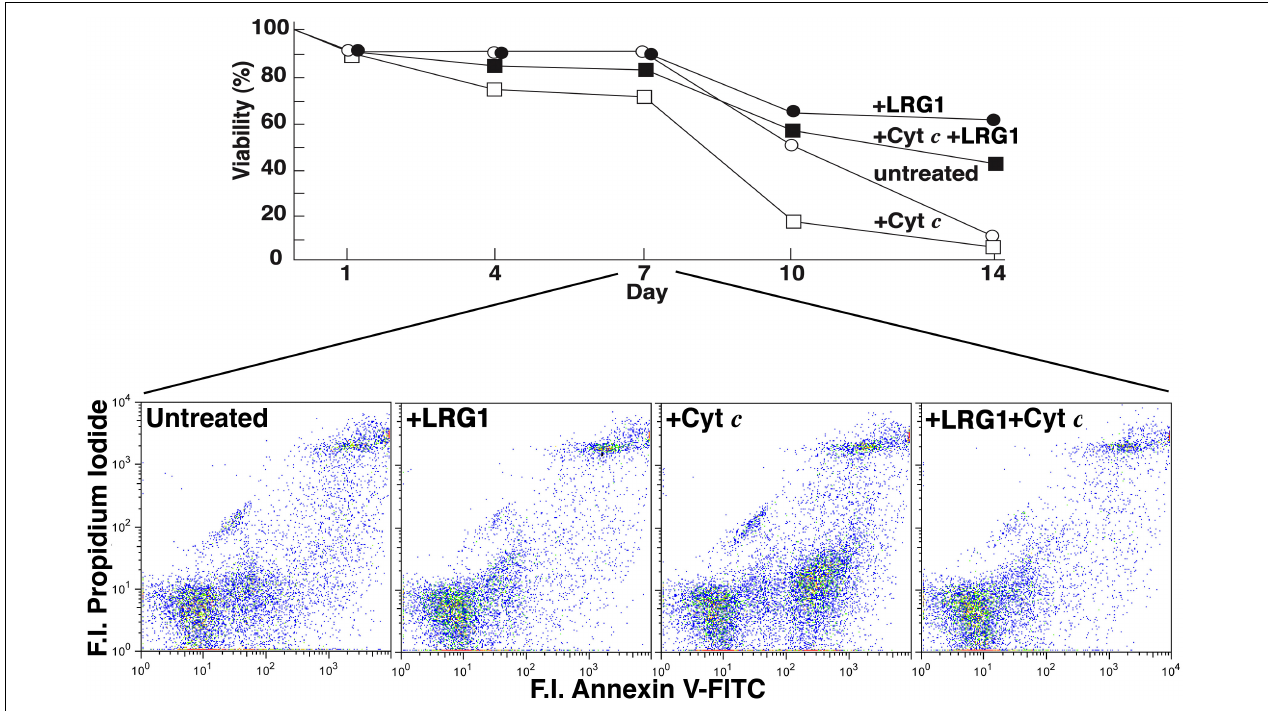
FIGURE 3 | Leucine-rich α 2 -glycoprotein-1 protects human lymphocytes from cell death induced by extracellular Cyt c . Cells were cultured in 10% fetal bovine serum-containing Dulbecco’s modified Eagle’s medium, depleted of LRG1 by adsorption on Cyt c -Sepharose 4B and supplemented with antibiotics. The lymphocytes (total blood mononuclear cells) were obtained from an individual, adult male donor. Either horse Cyt c (2 × 10 − 6 M), human LRG1 (2 × 10 − 8 M, purified from human plasma), or both were added to parallel cultures at t = 0. The concentrations of Cyt c and LRG1 employed had yielded optimal effects in preliminary experiments. In the top panel cultured lymphocytes were examined for secondary necrosis by trypan blue exclusion and, in the bottom panel, for apoptosis by flow cytometry. Necrotic but not apoptotic cells absorb trypan blue. Apoptotic cells bind annexin V-FITC and do not bind propidium iodide and so are present in the lower right quadrants in the bottom panel (F.I., fluorescence intensity). The % apoptotic cells at day 7 were 20% in the control culture, 10% in the culture supplemented with LRG1, 36% in the culture supplemented with Cyt c , and 9% in the culture supplemented with both Cyt c and LRG1. [The figure was adapted from Codina et al. (2010) with permission from the